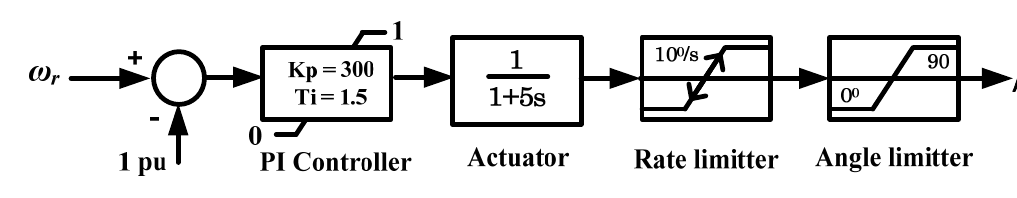
Figure 10. Pitch controller.